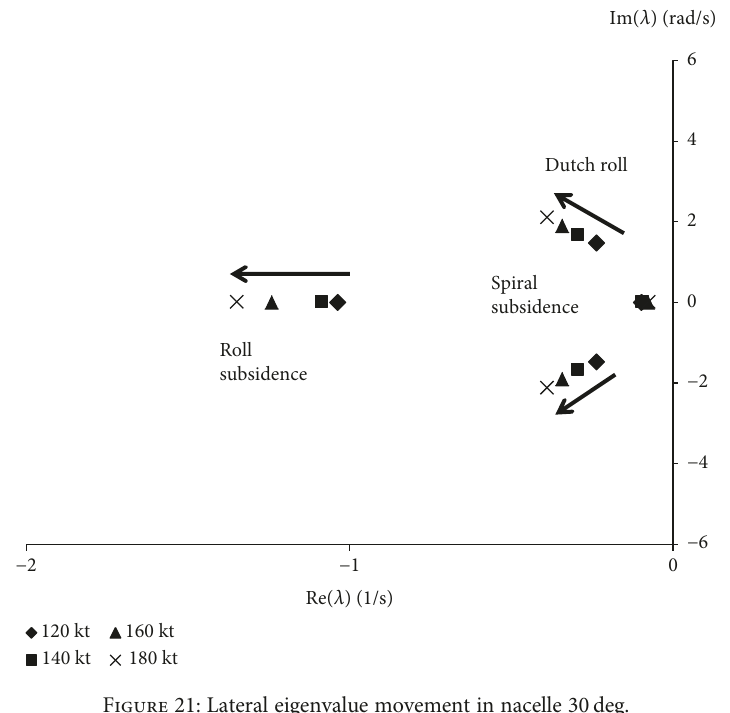
Figure 21: Lateral eigenvalue movement in nacelle 30deg.